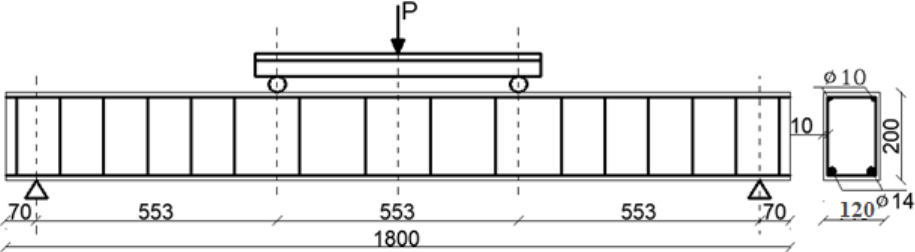
Figure 10. Static schemes and geometry of the beams of the V-th series (all dimensions in mm).